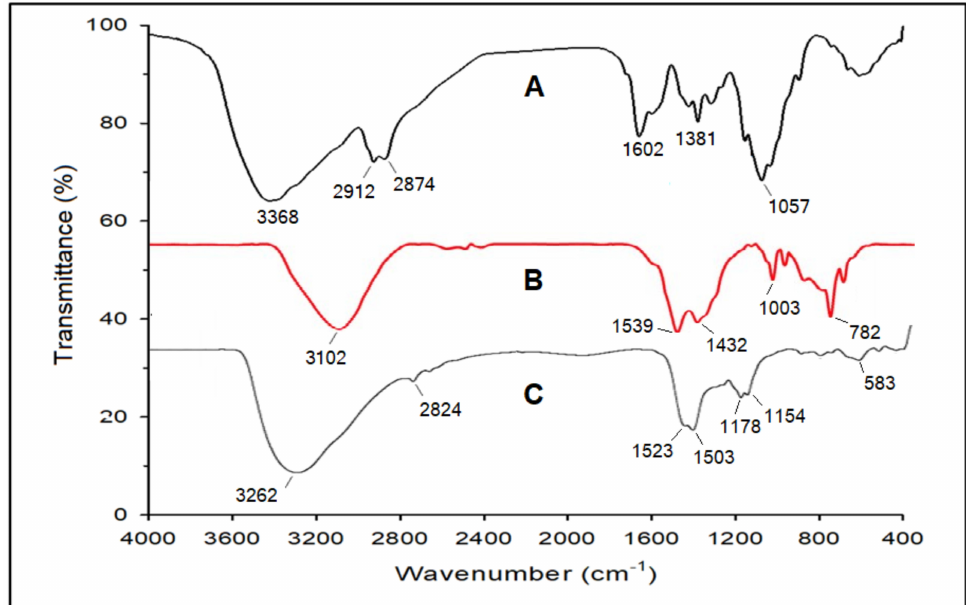
Figure 2. FTIR of pure chitosan ( A ), ZnO nanoparticles ( B ), and the chitosan − ZnO nanocomposite (20 wt.%) ( C